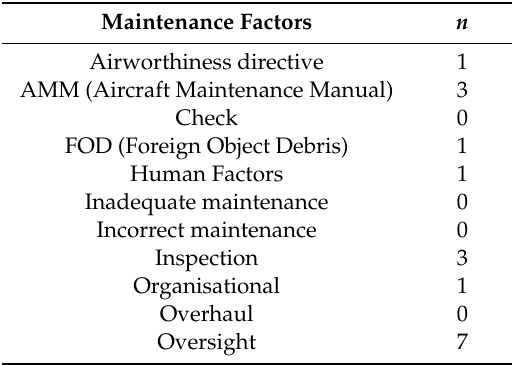
Table 8. Level 3 Maintenance